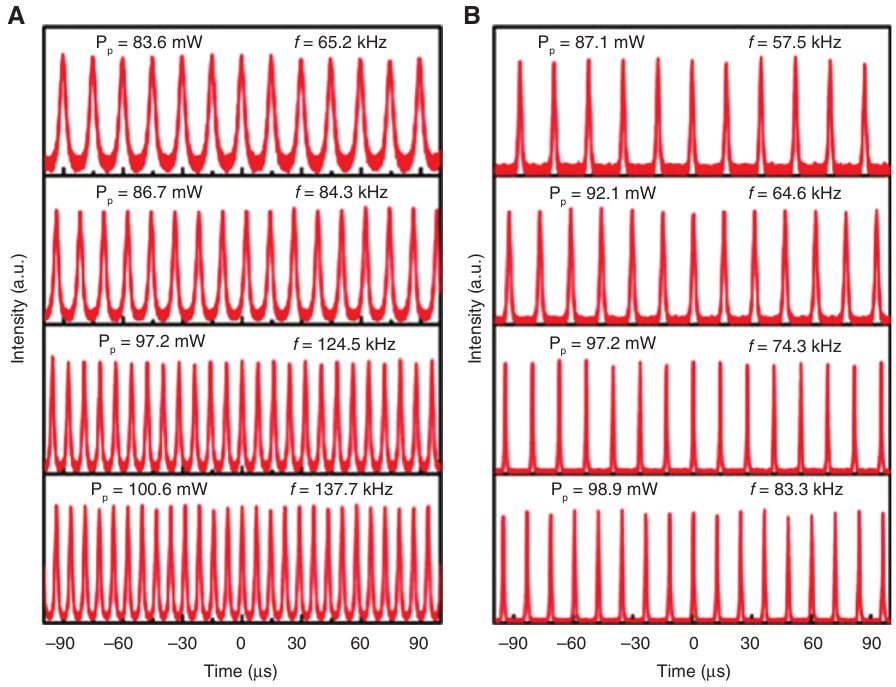
Figure 6: The pulse duration as short as 0.81 μ s was obtained. (A) Pulse train in the clockwise direction and (B) pulse train in the counter clockwise direction versus the incident pump power from the CNTs Q-switched Pr:ZBLAN laser at 635 nm. Li et al. [53] © IEEE